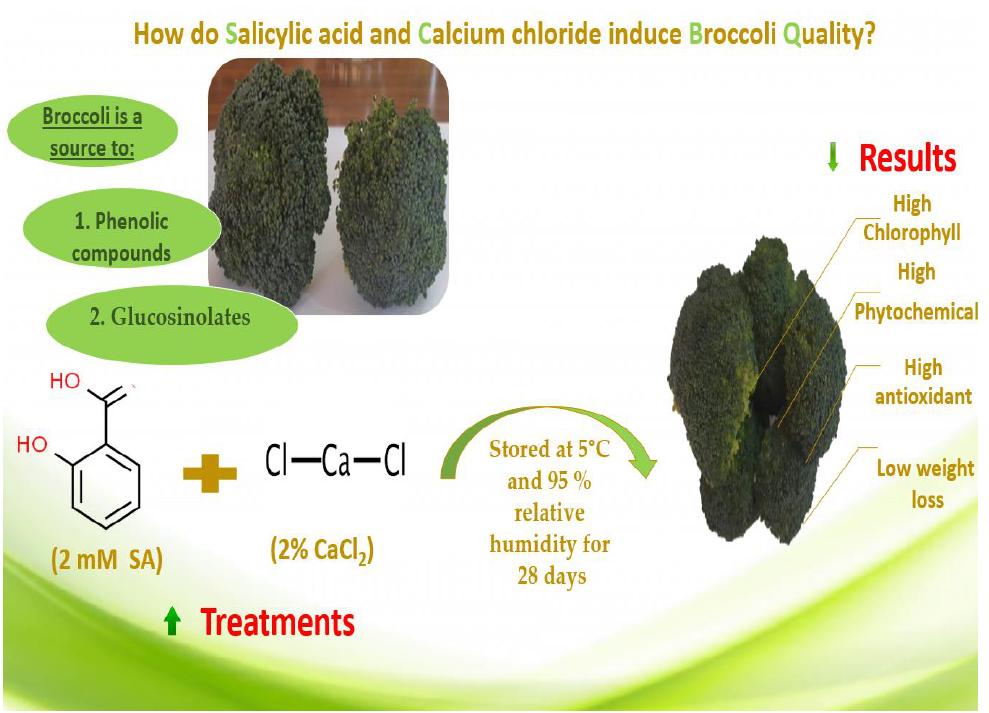
Figure 7. Graphical chart explains the effects of SA and CaCl 2 on broccoli florets.